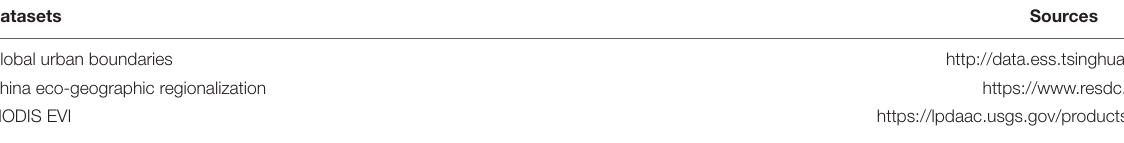
TABLE A3 | All data sets used and their